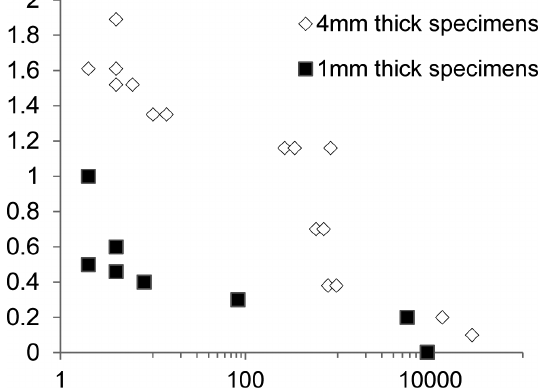
Fig. 4. Impact energy (E) vs number of of impacts to failure (Nf) during IF in semi-logarithmic coordinates.